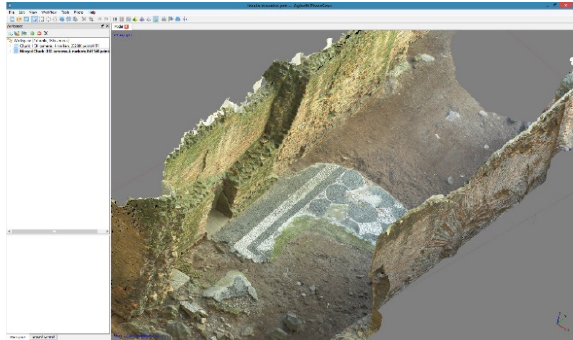
Fig. 20 Image-based 3D model of mosaic floor and wall in area called C3, visualized as colour mode.